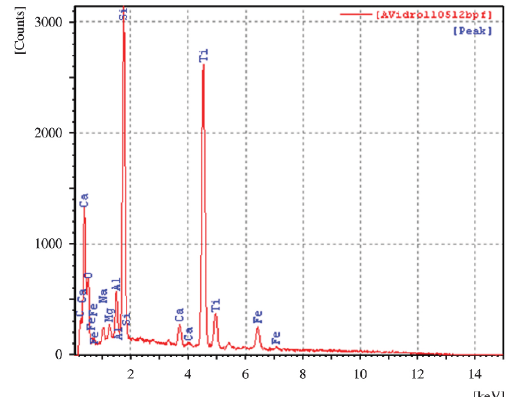
Figure 4. EDS graphics showing the chemical composition of the deposited film in double titanium cage at 350°C - 3 hours, 12 sccm de H + 04 sccm de N /H (80% N 2 2 2 2